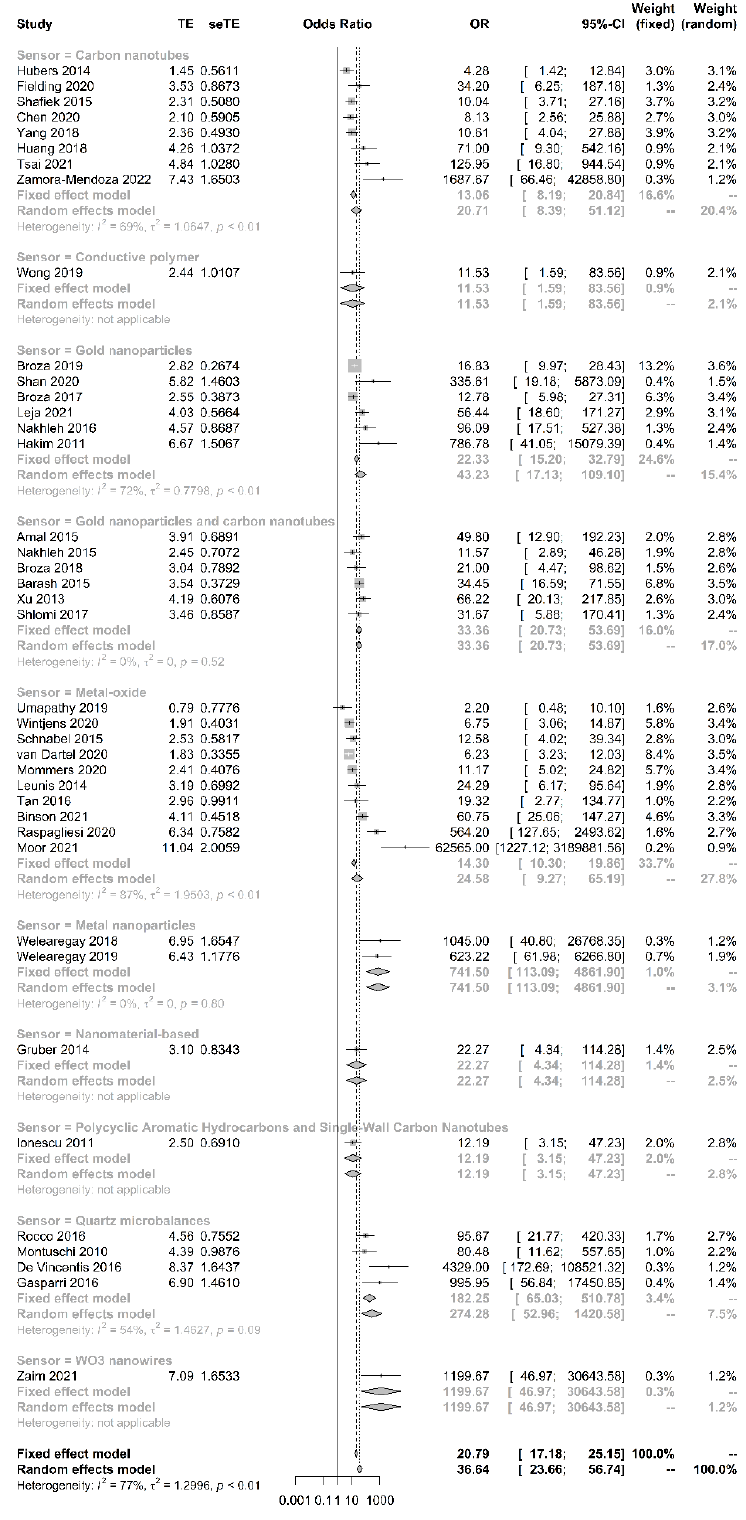
Figure 6. Subgroup analysis for pooled diagnostic odds ratio based on the type of sensor. The type of sensor is based on the classification provided in the literature.